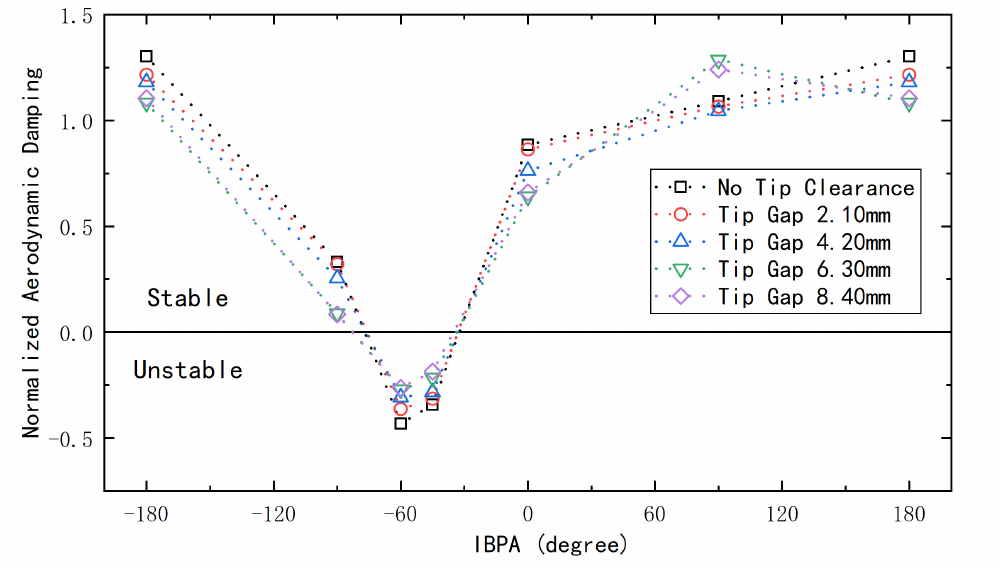
Figure 7. Aerodynamic damping versus IBPA with various tip gap